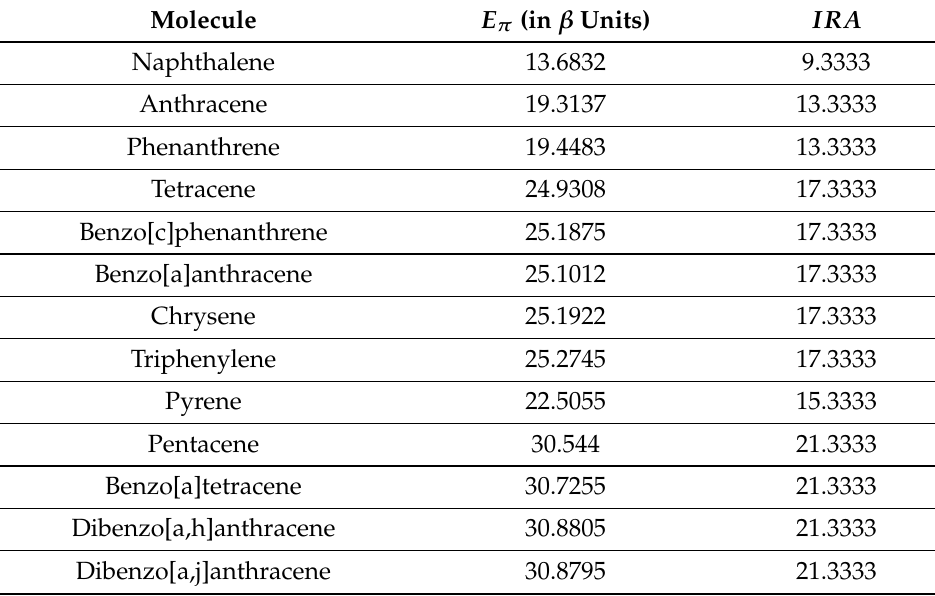
Table 4. The experimental data of E π and the IRA index of the 29 lower PAHs.